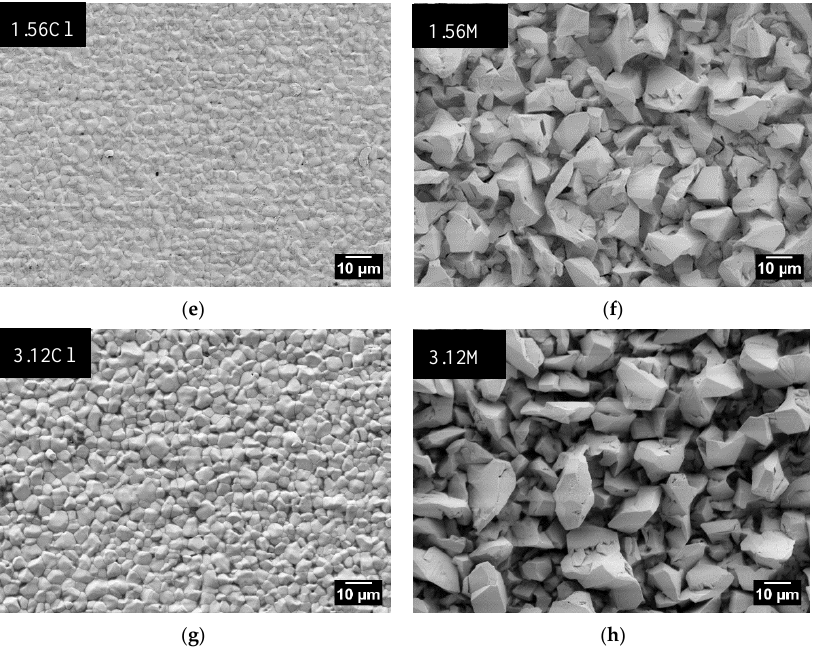
Figure 10. Surface topography of the samples deposited from non-stirred solution with increasing ABN concentration: 0, 0.78, 1.56, 3.12 mg/L, from chloride based electrolyte in ( a , c , e , g ), and from MSA electrolyte ( b , d , f , h ). Table 5. Average grain size ( l ) with standard deviation (S.D.) for the samples deposited from chloride based and MSA